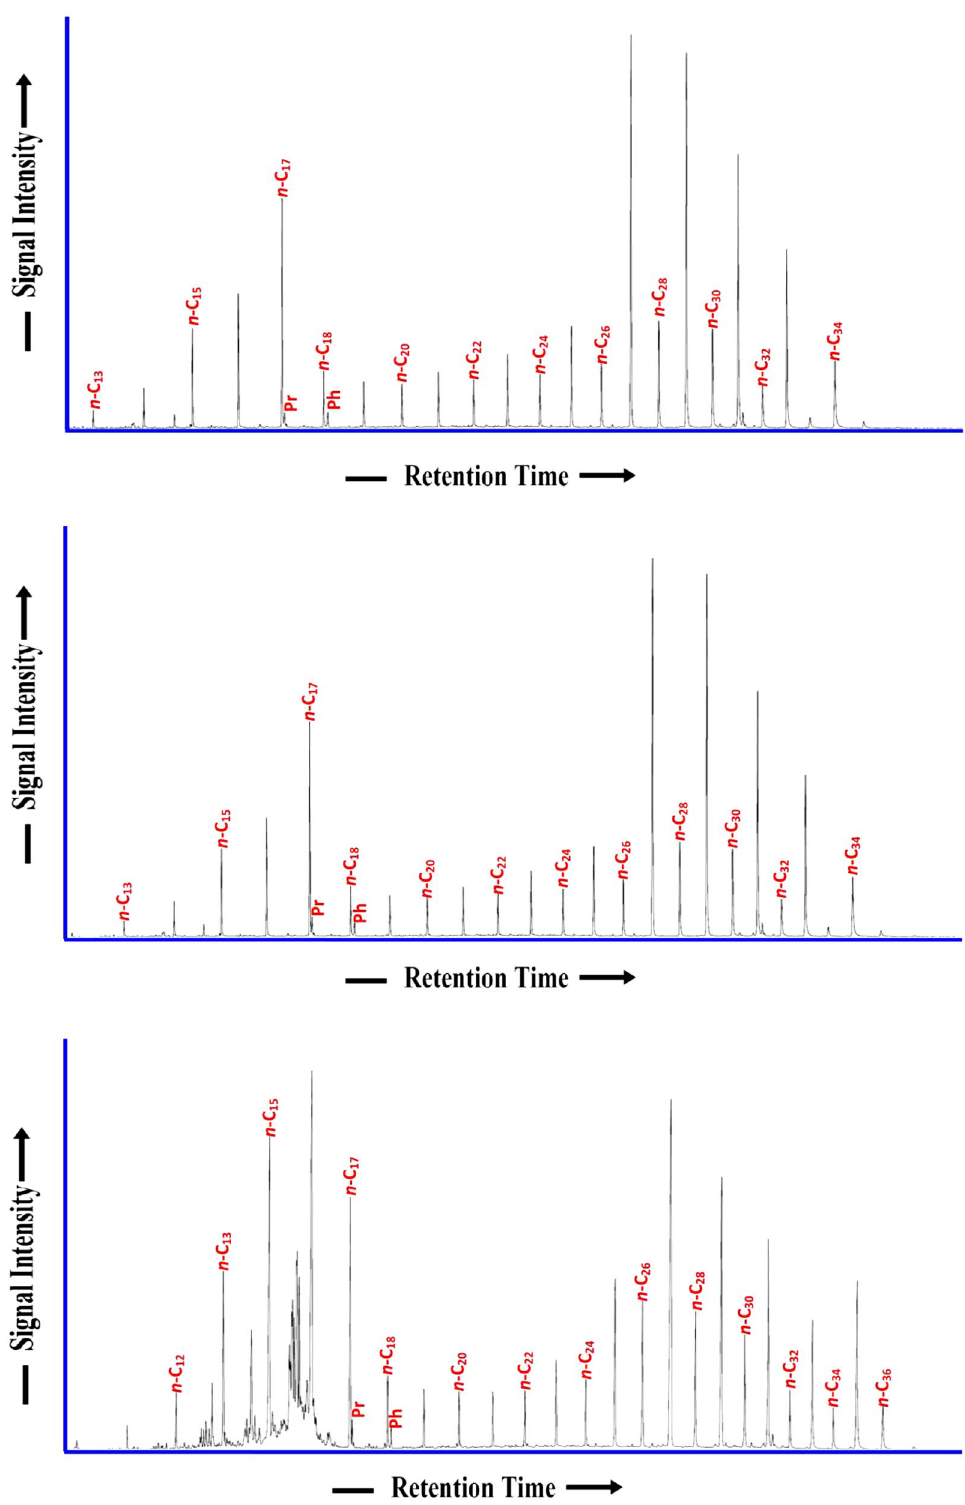
Figure 10. n -alkane and isoprenoid distribution according to m/z 85 of the selected studied shale